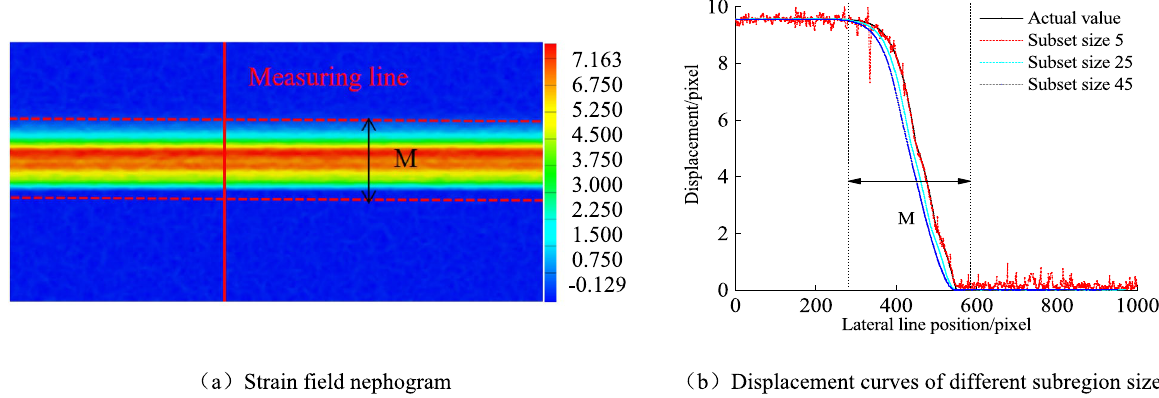
Figure 5. Numerical simulation of strain localization